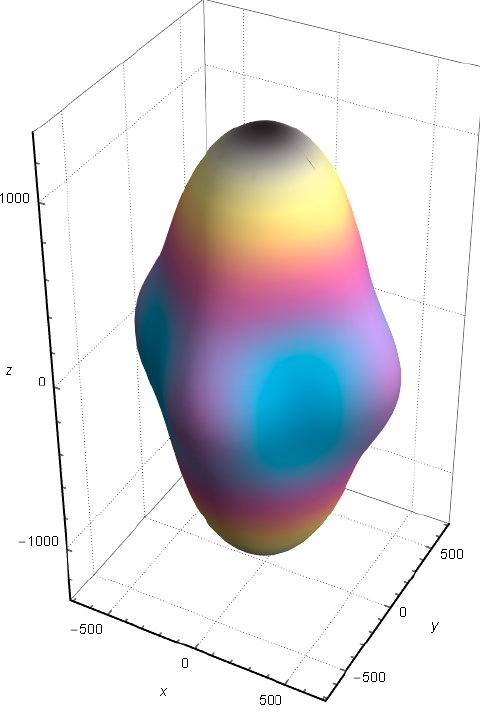
Figure 9. Calculated direction-dependent Young’s modulus of SrCu 2 O 2 .